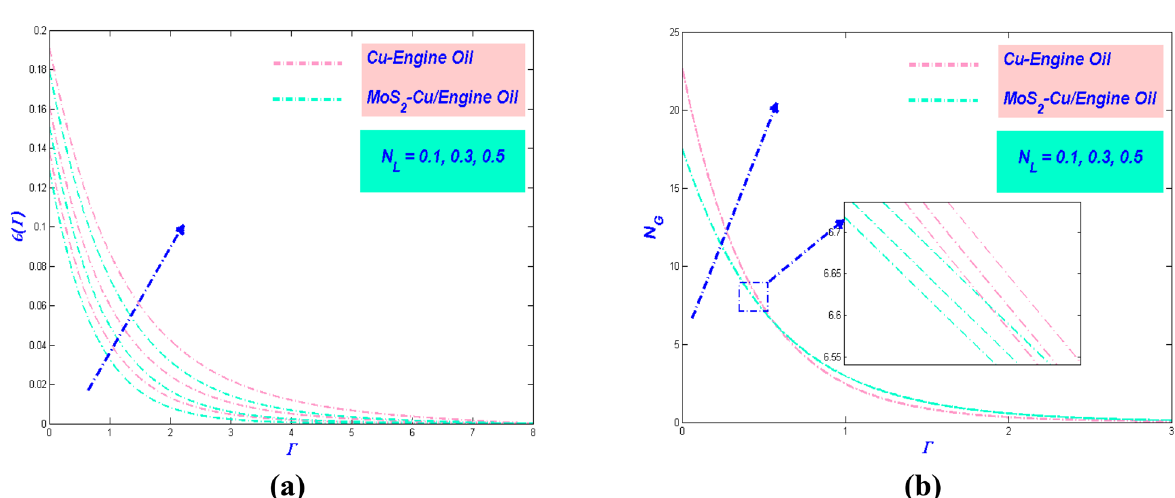
Figure 10. ( a ) Temperature and ( b ) entropy variations versus N L